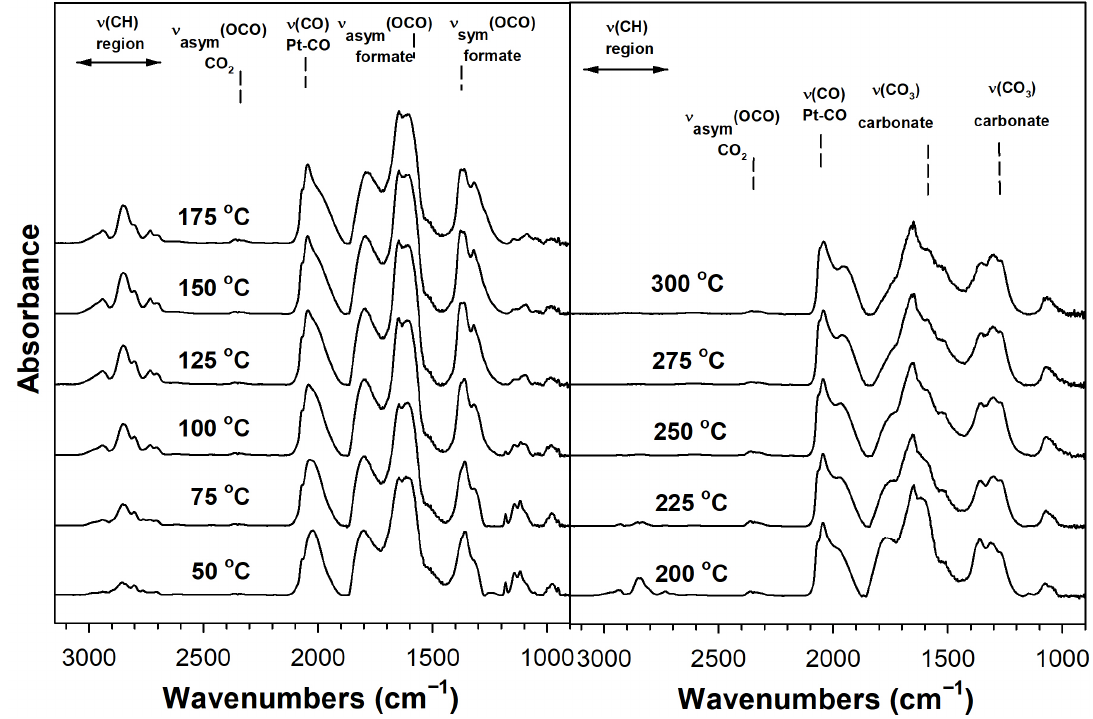
Figure 4. DRIFTS of steam reforming of formaldehyde over 1%Na-2%Pt/m-ZrO 2 .